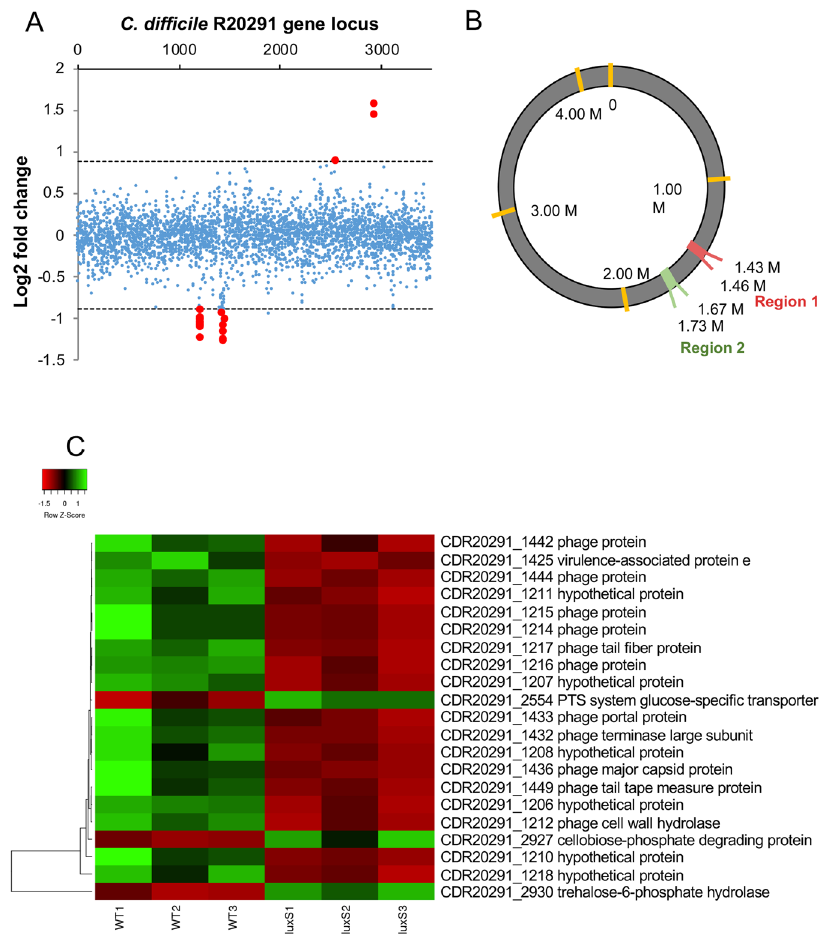
Figure 2. Down-regulation of prophage genes in the C . difficile luxS mutant. ( A ) Pairwise analysis identified 21 differentially expressed genes in luxS (red points). All 18 down-regulated genes clustered into two regions. ( B ) Three prophage regions are identified in the C . difficile genome using Phaster. Regions 2 and 3 were down regulated in luxS . ( C ) Heat map representation of the genes that were differentially expressed in luxS, red and green indicate down- and up-regulation respectively when compared to WT. 18 prophage genes were found to be down-regulated in luxS relative to WT, whilst two genes involved in trehalose metabolism were up-regulated in luxS relative to WT. Data shown is the mean of 3 independent experiments in triplicates. Differential expression was defined as ≥ 1.6-fold change relative to WT with an adjusted p -value ≤